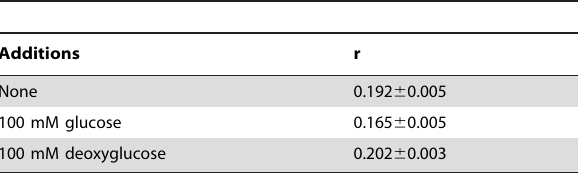
Table 3. Fluorescence depolarization (anisotropy) r of PMA1- GFP in whole cells after 15 min incubation with 100 mM glucose or